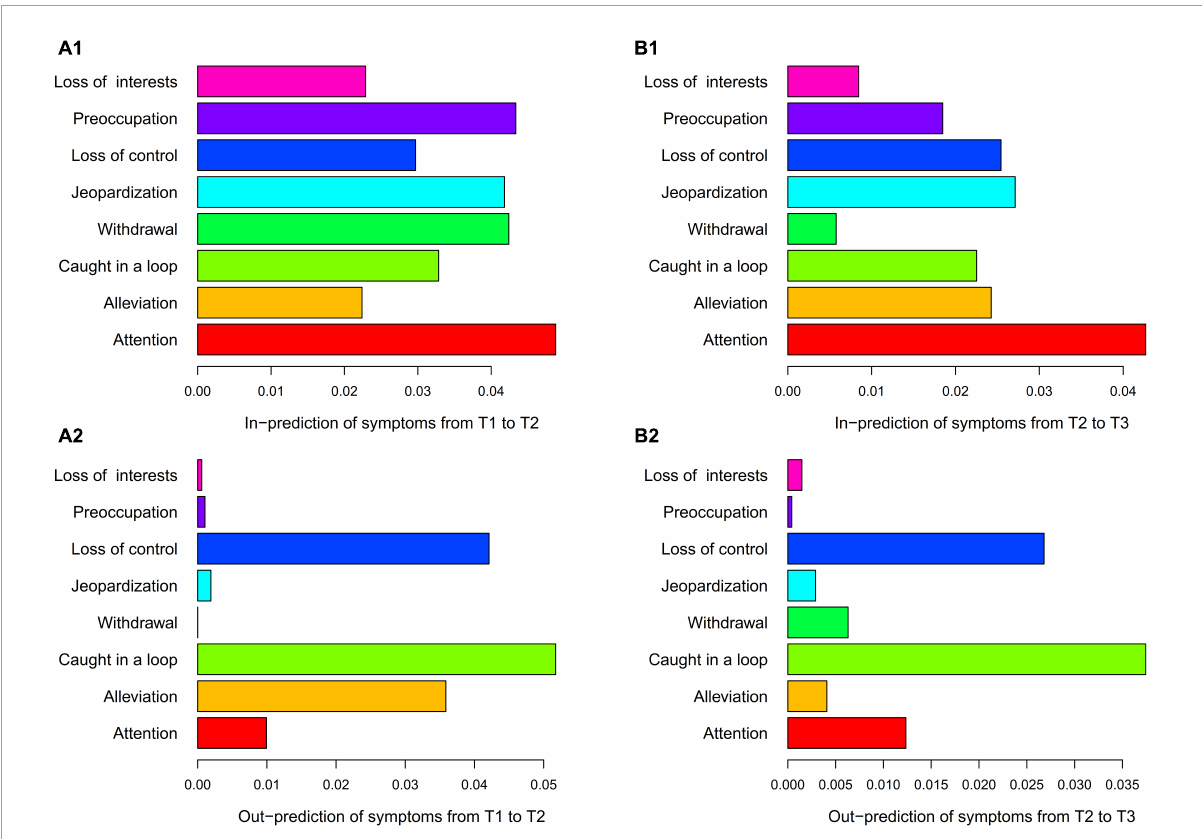
FIGURE2 The centrality of the CLPM of PSU. (A1) is in-prediction of symptoms from T1 to T2, (A2) is out-prediction of symptoms from T1 to T2, (B1) is in-prediction of symptoms from T2 to T3, and (B2) is out-prediction of symptoms from T2 to T3. CLPM is the cross-lagged panel model. The in- and out-predictions were summed by the squared regression paths from one symptom to another. According to the suggestion of Rhemtulla et al. (27), the autoregressive path was excluded when calculating prediction to highlight the cross-lagged